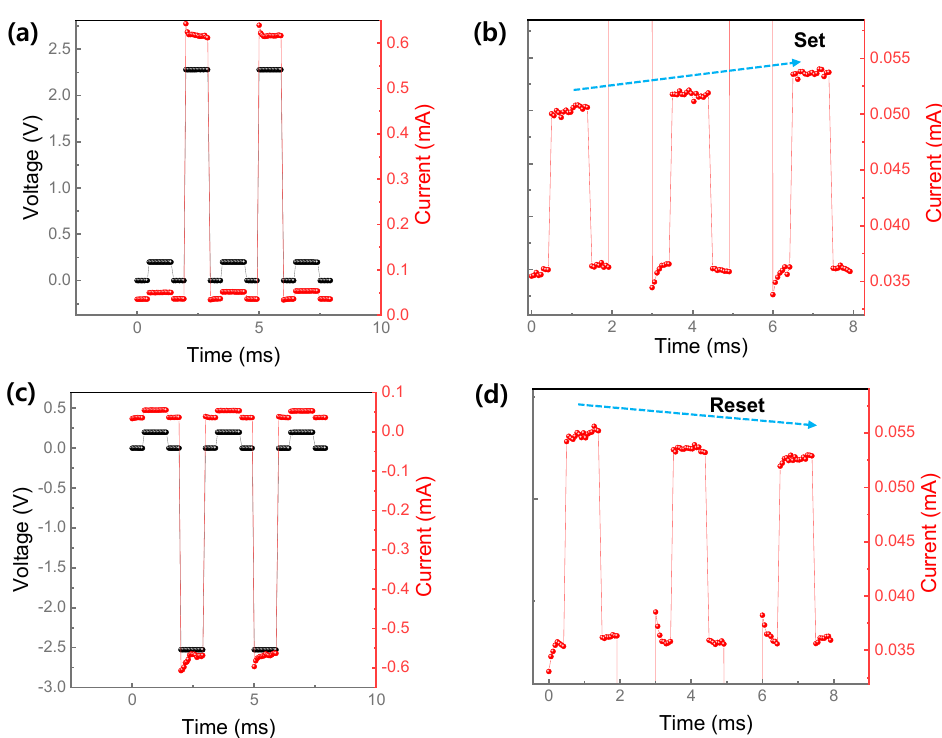
Figure 4. ( a ) Transient characteristics and ( b ) current part is expanded by set pulses. ( c ) Transient characteristics and ( d ) current part is expanded by reset